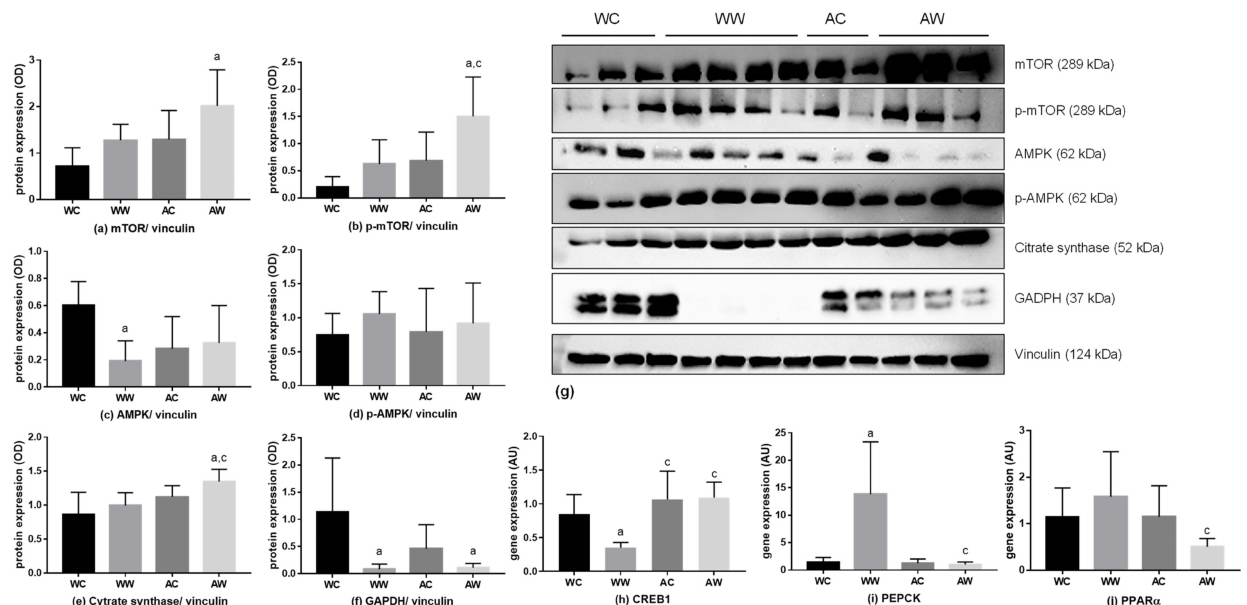
Figure 3. Protein and gene expression in the liver of weanling and adult control and tumour-bearing animals. Western blot analysis from: ( a ) total mTOR; ( b ) phosphorylated mTOR; ( c ) total AMPK; ( d ) phosphorylated AMPK; ( e ) citrate synthase; ( f ) GAPDH; ( g ). The western blot images are representative of the total analysis of all animals in each group. Rt-PCR analysis for gene relative expression of: ( h ) CREB1 , ( i ) PEPCK and ( j ) PPAR α . Legend: WC, weanling control group ( n = 7); WW, weanling tumour-bearing group ( n = 10); AC, adult control group ( n = 6); AW, adult tumour-bearing group ( n = 8). Data were expressed as mean ± standard deviation (SD). The units used were as follows: ( a – f ): protein/vinculin protein expression (optical density, OD—western blot image) and ( h – j ): relative protein expression (rt-PCR; expressed as arbitrary unit- AU). Data were analysed by two-way ANOVA and corrected for multiple comparisons by the post hoc test Bonferroni. a represents differences from the WC group and c indicates differences from the WW group. Differences were significant when p <